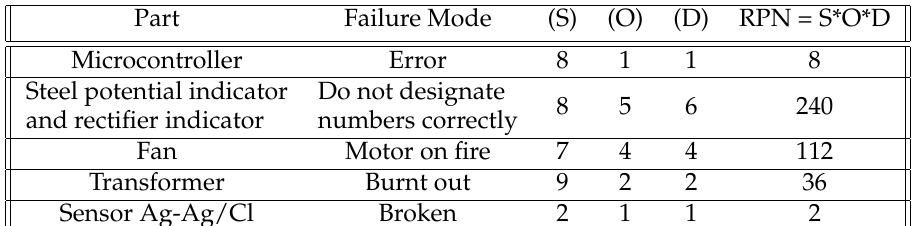
Table 5. Result of Risk Priority Number (RPN) scores for Failure in ICCP.